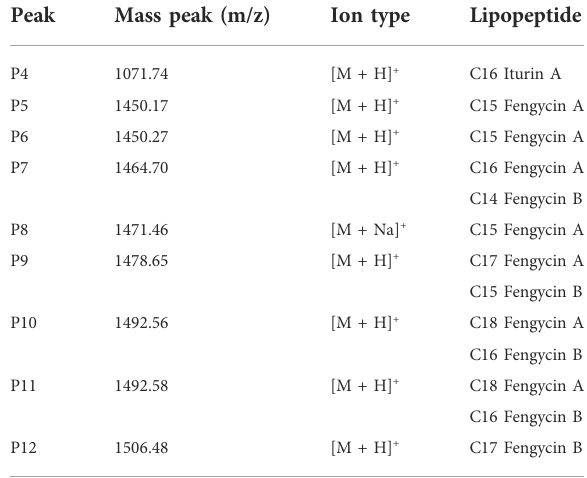
TABLE 2 Characterization of lipopeptides by m/z in P4 –